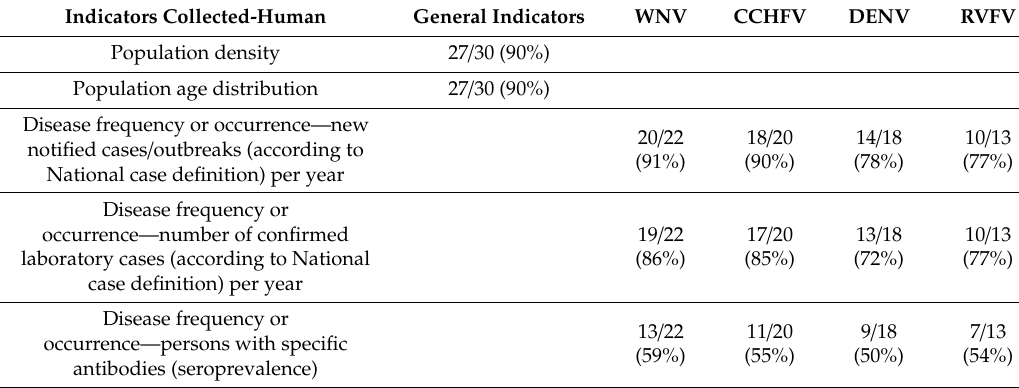
Table 6. Collection of selected indicators for humans for WNV, CCHFV, DENV, and RVFV.